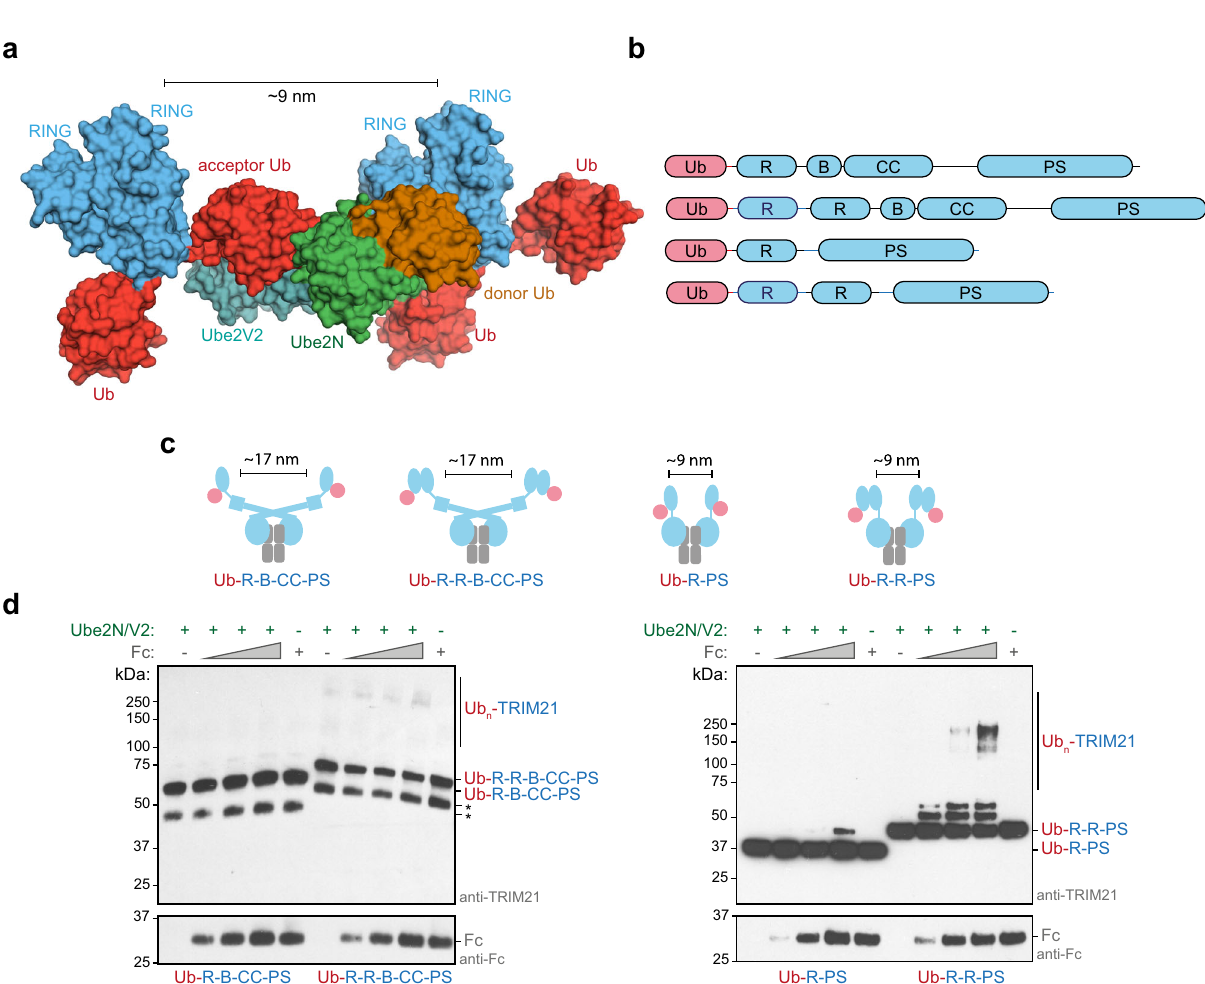
Fig. 3 The mechanism of RING-anchored ubiquitination in trans . a Surface representation of the canonical model of the Ub-R:Ube2N~Ub: Ube2V2 structure (Ub-R, Ub in red, R in blue, Ube2N~Ub, Ube2N in green, Ub in orange, and Ube2V2 in teal). b Domain architecture of TRIM21 constructs used in biochemical assays. c Cartoon models of substrate (Fc, gray) engagement by TRIM21 constructs (blue). The structural basis for these models is shown in Supplementary Fig. 8. d Substrate (Fc)-induced self-ubiquitination assay of 100 nM Ub-TRIM21 constructs. Reactions were incubated for 5 min at 37 °C. Further data can be found in Supplementary Fig. 9. * (asterisk) indicates a TRIM21 degradation product that could not be removed during puri fi cation. Western blots are representative of n = 3 independently performed experiments. Uncropped blots are provided in Source data. Ub ubiquitin, R RING, B Box, CC coiled-coil, PS PRYSPRY, kDa kilo